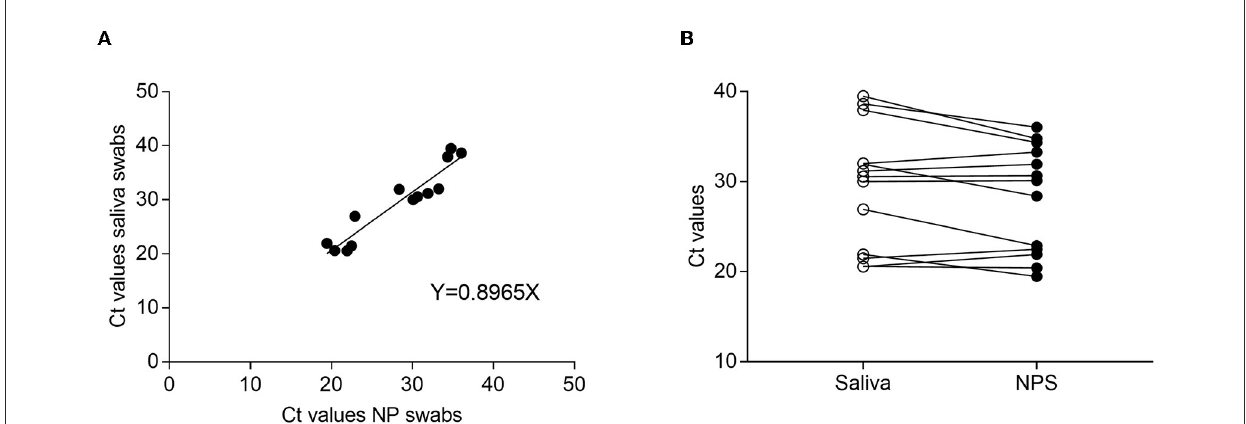
FIGURE1 C t comparison between NPS and saliva-paired samples. (A) Regression curve of C t obtained from NPS and saliva samples. The graph shows a linear correlation between specimens with an R 2 value of 0.8965. (B) Correlation between positive paired samples.